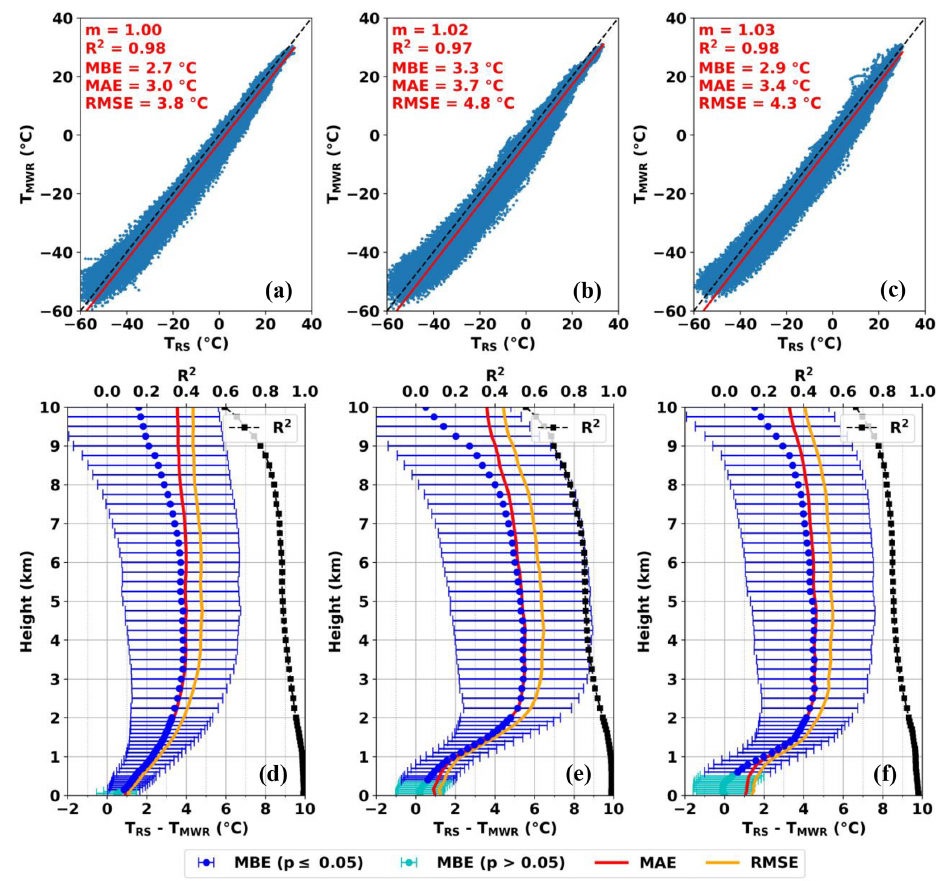
Figure 6. Scatterplots for RS- and MWR-measured temperature ( T ) at three NYSM Profiler Network sites at (a) Buffalo, (b) Albany, and (c) Stony Brook. Vertical profiles of R 2 , MBE with one standard deviation error bars, MAE, and RMSE for the same variable at (d) Buffalo, (e) Albany, and (f) Stony Brook.